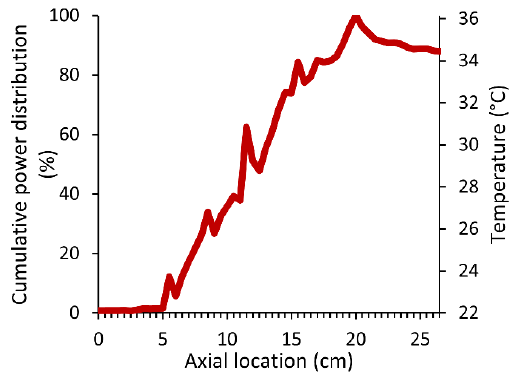
Figure A1. The cumulative ultrasonic power distribution along the length of the ultrasonic nucleator. The power distribution is derived from the temperature increase and the nucleator is 26.5 cm long from the left to right.